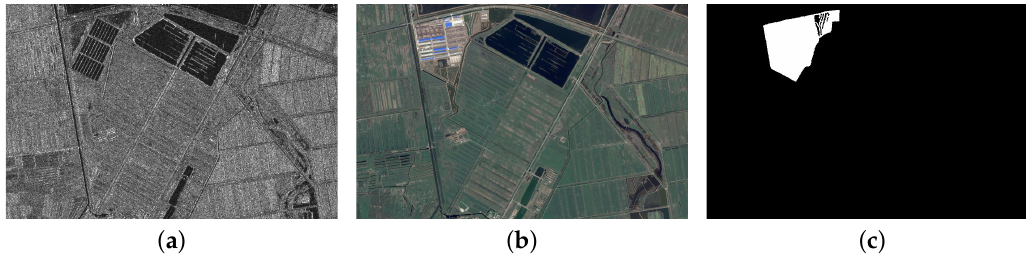
Figure 8. Shuguang Village dataset. ( a ) SAR image acquired in 2008. ( b ) Optical image acquired in 2012. ( c ) Reference